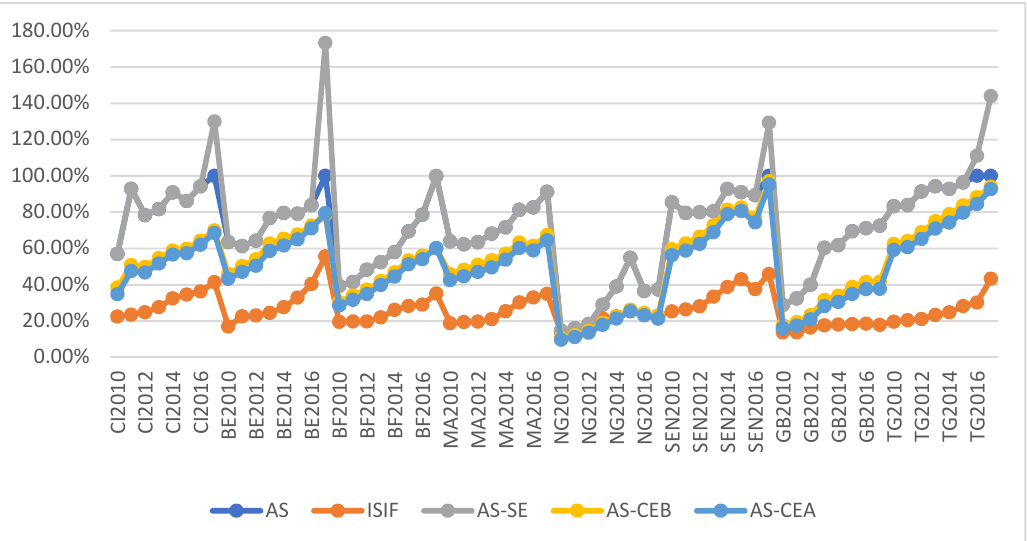
Figure 1. ISIF, AS, AS–SE, AS–CEB, and AS–CEA for the sample. We observe an apparent concordance between the scores for all the DMUs, as their patterns are highly similar.